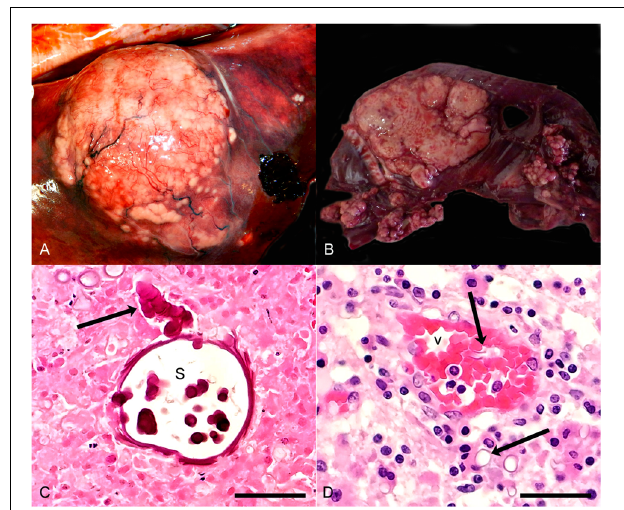
FIGURE 2 | (A) Harbor porpoise, pulmonary abscess. Note large bulging white nodular mass in lung. (B) Harbor seal, Pulmonary abscesses. Note variably sized irregular nodular white masses. (C) Harbor porpoise, lung. Note undulating, broad, septate intensely eosinophilic fungal element (arrow), terminating in a large spherical sporangium (s). Pulmonary tissue around the fungi is necrotic. HE, bar = 75 µ . (D) Harbor porpoise, brain. Note small blood vessel (v) with luminal and perivascular fungal elements (arrows). The neuropil around the vessel is infiltrated by low numbers of plasma cells, lymphocytes and histiocytes. HE, bar = 75 µ